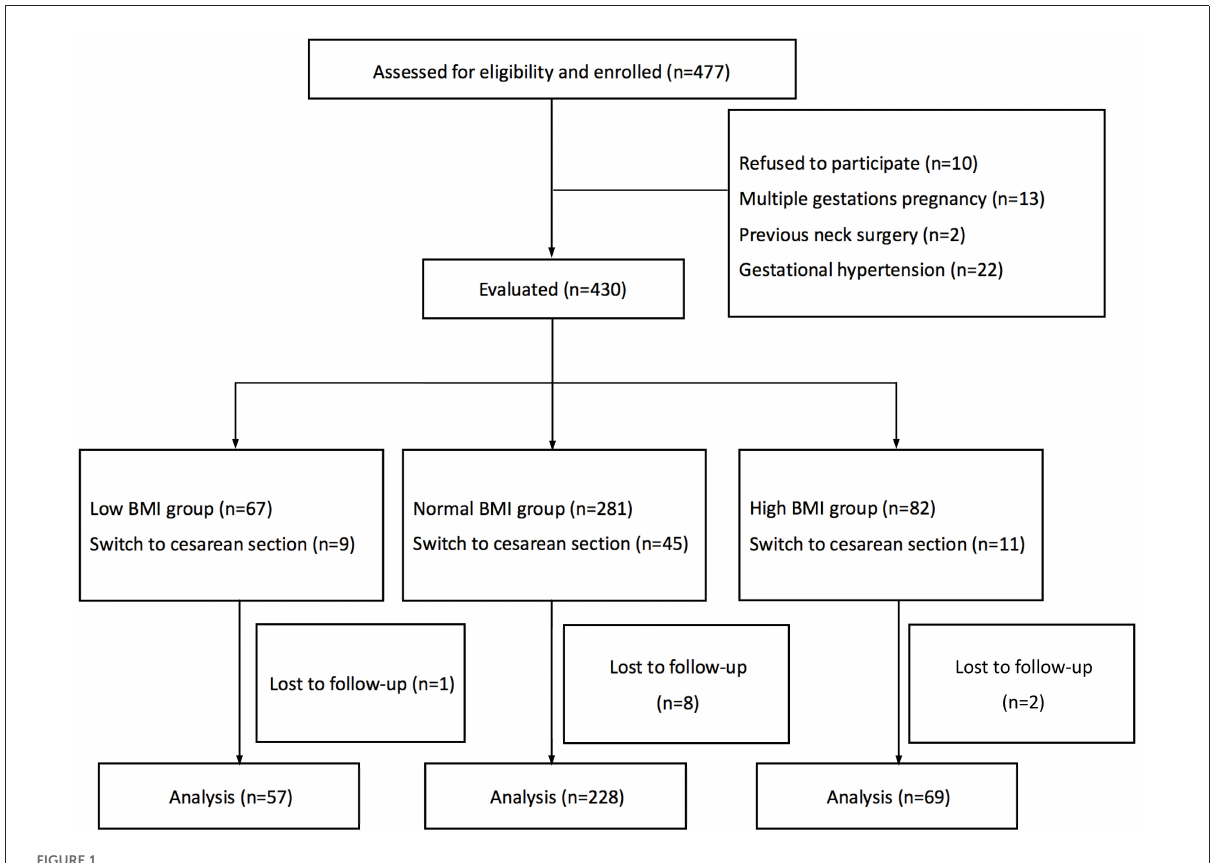
FIGURE1 Recruitment flow chart. BMI, body mass